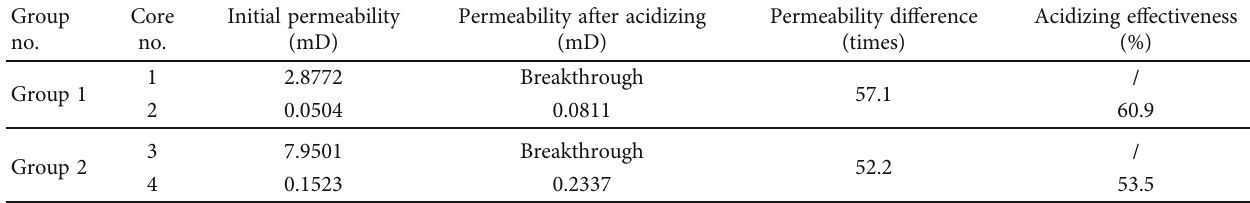
Figure 2: Friction of three kinds of liquids. Table 3: Double-core acidi fi cation experiment